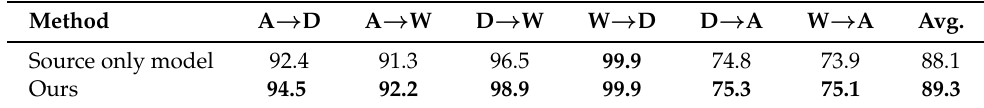
Figure 6. Feature visualization of task A → W, office-31. ( left : source-only model; right : ours) Table 6. Impact of not label consistency. Accuracies (%) on office-31 dataset